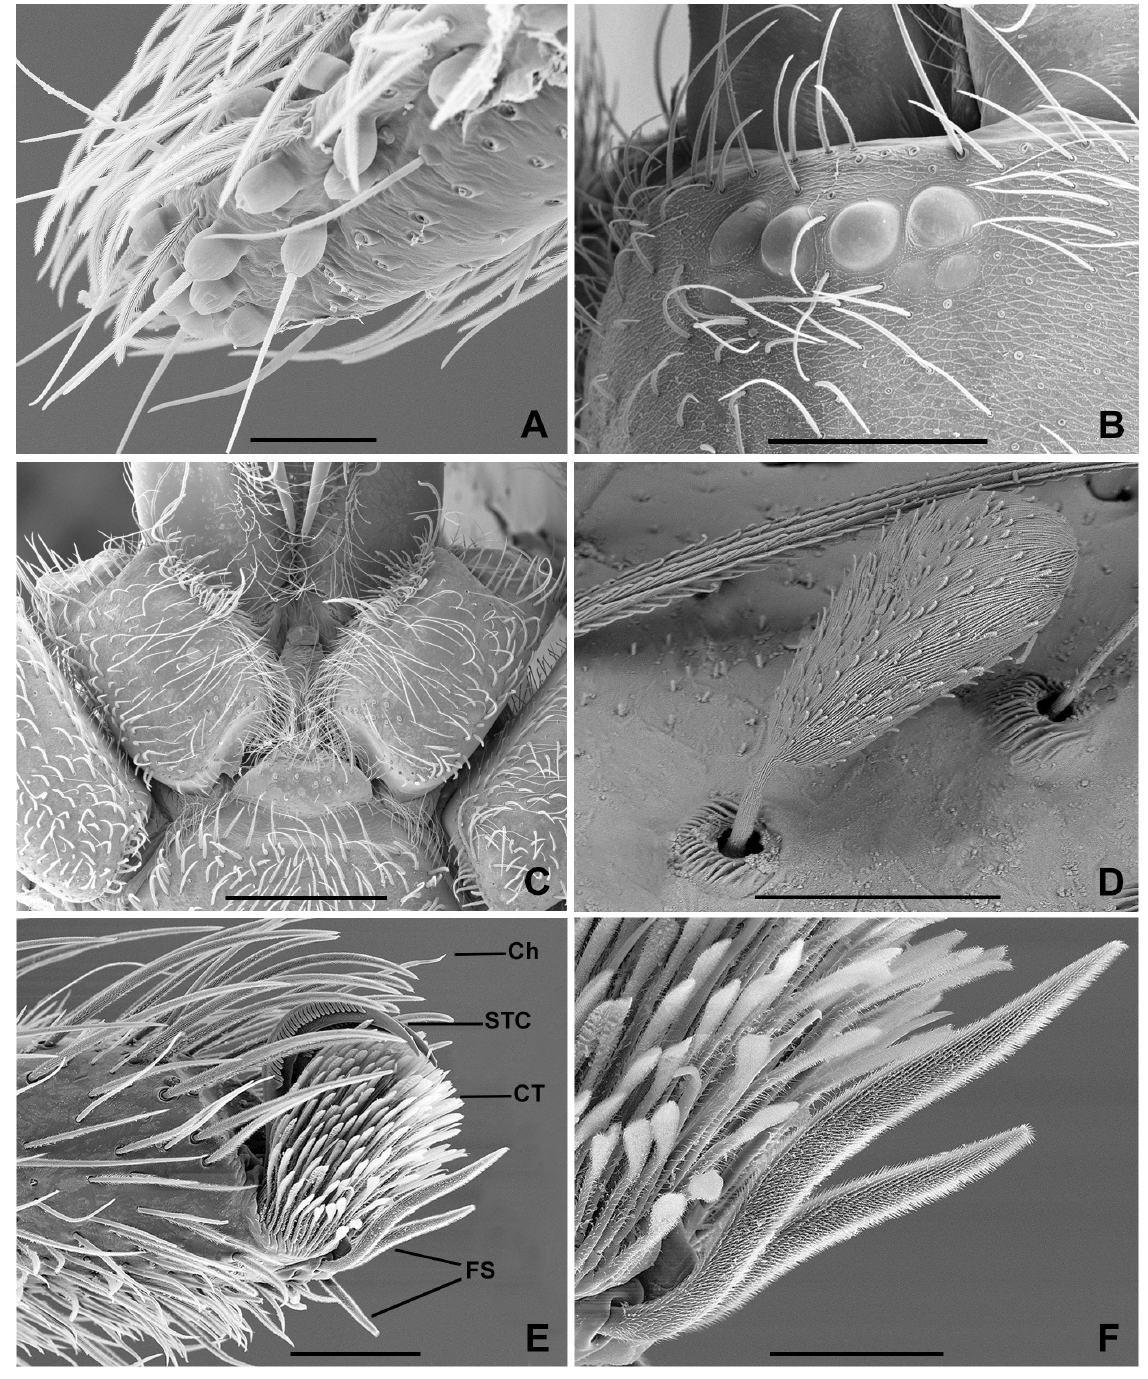
Fig. 4. SEM micrographs of Ammonius pupulus Thorell, 1899, ♂ (RMCA 227221). A . Apical segment of PLS. B . Eye group, lateral view. C . Maxillae and labium, ventral view. D . Clavate trichobothria. E . Apical of the tarsus I, lateral view. F . Detail of frictional setae, lateral view. Abbreviations: Ch = chemosensory setae; CT = claw tufts; FS = frictional setae; STC = superior tarsal claws. Scale bars: A, F = 50 µm; B = 300 µm; C = 500 µm; D = 5 µm; E = 100